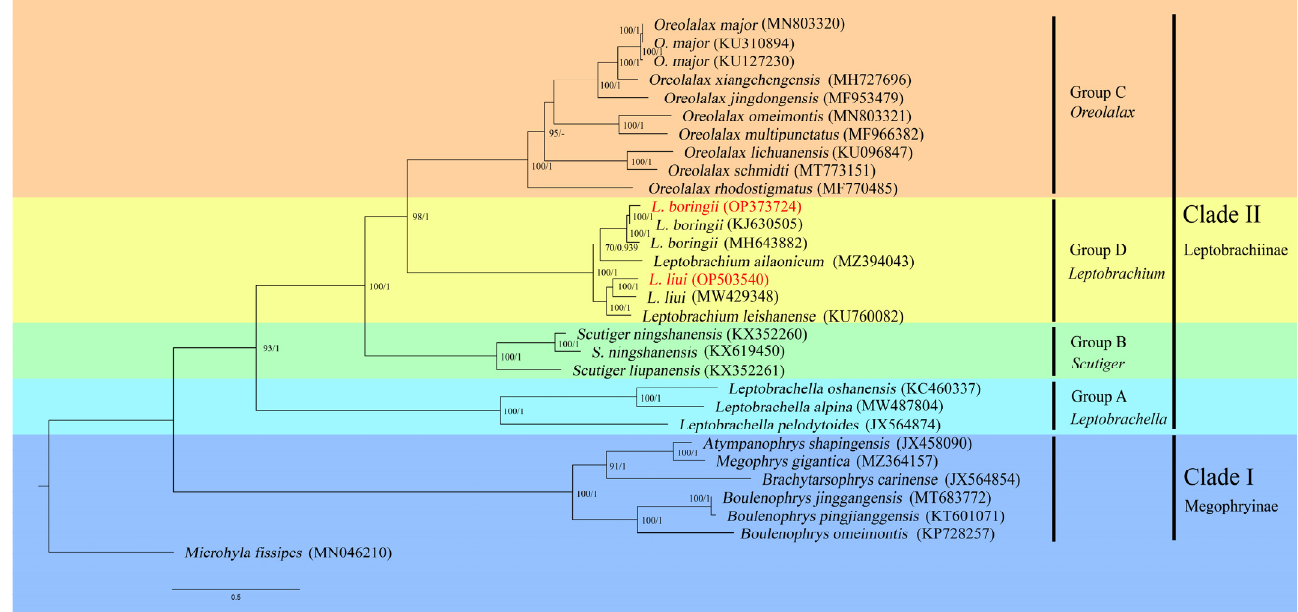
Figure 6. Phylogenetic relationships within Megophryidae derived from ML method based on 13 PCGs. Note: The numbers on the branches represent the bootstrap values and posterior probabilities of ML/BI analyses. The number after species name is the GenBank accession number. Names in red show the phylogenetic positions of L. boringii and L. liui that we sequenced in this study.